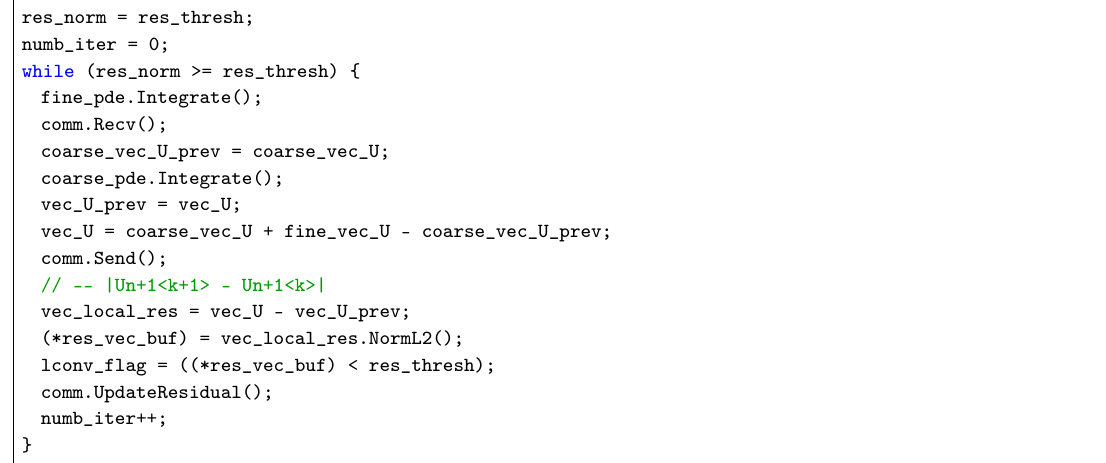
Listing 11: Asynchronous parareal iterative